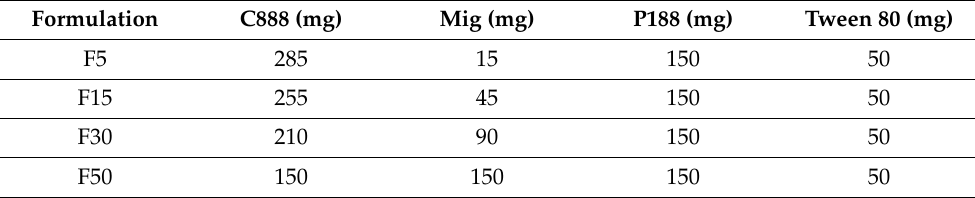
Table 1. Description for the quantities of excipients used for NLC formulations.